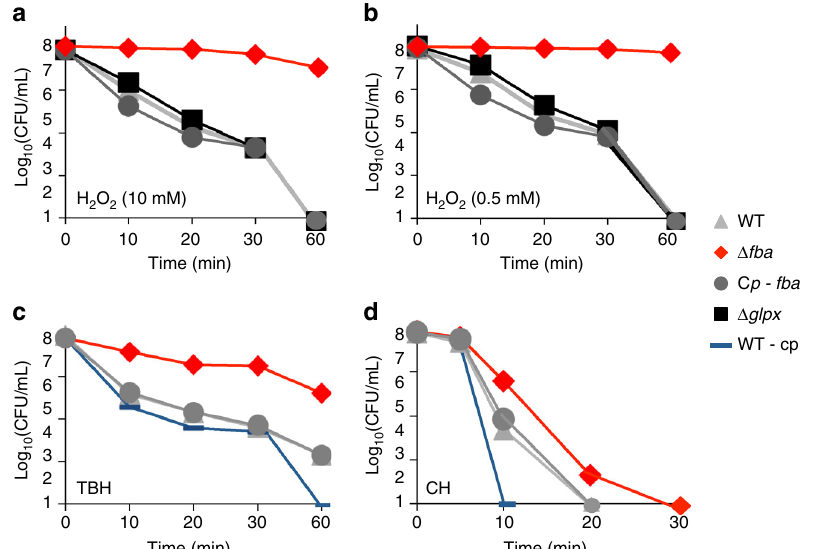
Fig. 4 Oxidative stress survival. After an overnight culture in CDM supplemented with glucose and glycerol, bacteria were diluted in PBS and were subjected to oxidative stress a 10 mM H 2 0 2 , b 500 µ M H 2 0 2 , c Tert-butyl hydroperoxide 10 mM (TBH), and d Cumene hydroperoxide 10 mM (CH). Bacteria were plated on chocolate agar plates at different time points and viable bacteria were numerated 2 days after. Experiments were realized three